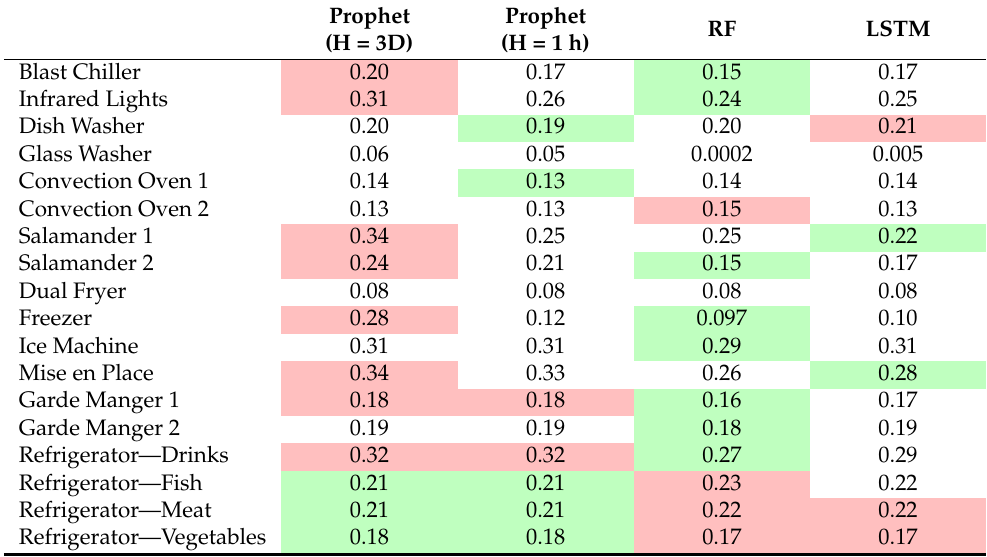
Table 3. Performance metrics of different algorithms’ comparison for individual appliances (NRMSE).